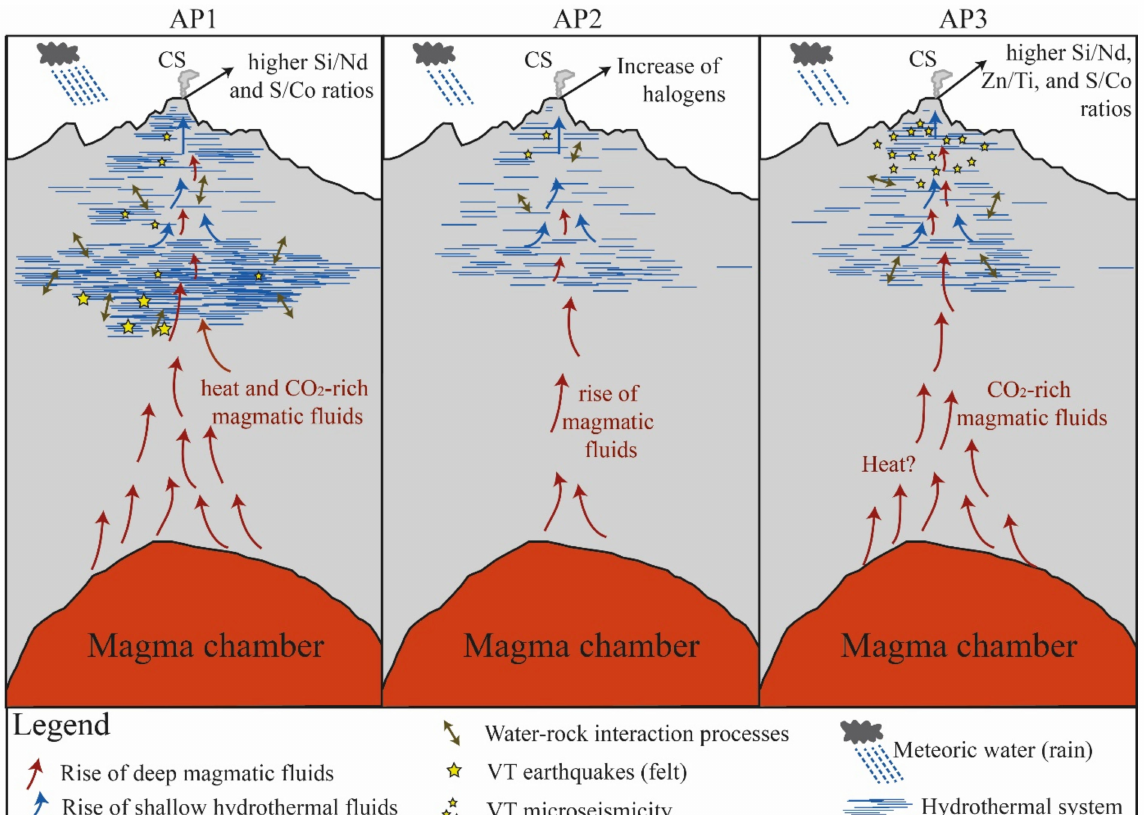
Figure 7. Sketch describing the three anomalous periods (AP1, AP2, and AP3). These conceptual models summarize the internal and external factors that produced APs, focusing on the input of deep magmatic gases, the water–rock interaction processes, the input of meteoric water (rainfall), and the amount of water within the hydrothermal system that enhances or decreases the magmatic signal of discharged fluids. Further details in the text. Figures are not to